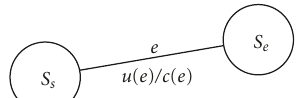
Figure 6: BCJR notation on the